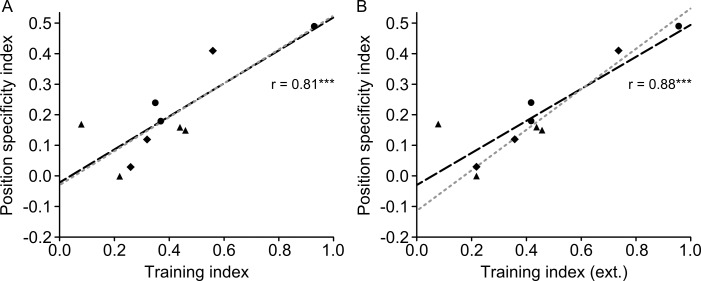
Scatterplot of position specificity and training indices.A, Position specificity correlates positively with the training index. B, The correlation between position specificity and training index was even stronger when using the complete learning data (including extra thresholds and refresher training) for calculation of the training index. The black dashed line results from an ordinary least square regression (r also obtained from that analysis), whereas the grey dotted line was fitted with betas obtained by using robust regression. Different symbols represent different training schemes: triangle = 15 sessions with 4 staircases, circle = 10 sessions with 8staircases, diamond = 15 sessions with 4 staircases plus 3 refresher sessions. * p < .050, ** p < .010, *** p < .005.